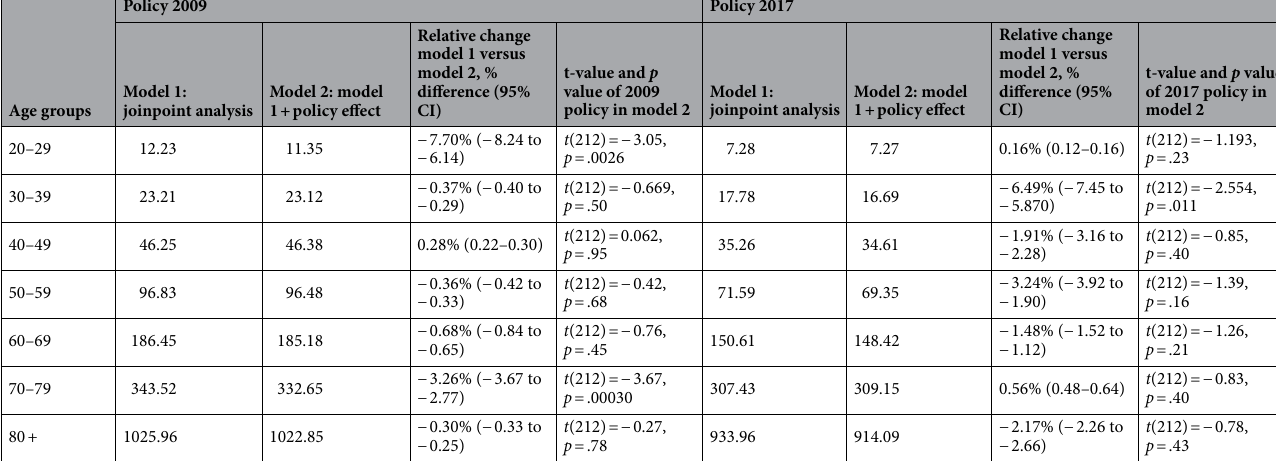
Table 3. Age-specific effects of the alcohol control policies implemented in 2009 and 2017, and the effect on monthly all-cause mortality rate (per 100,000 people) for the 12-month period following policy